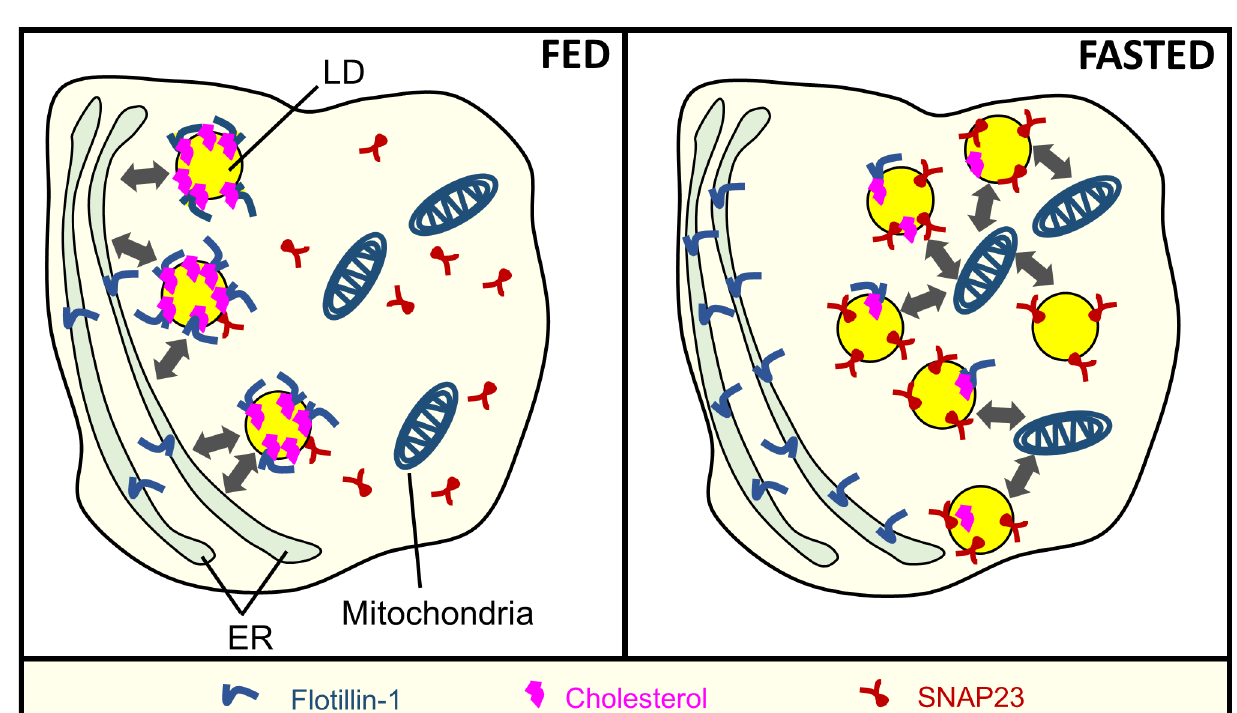
Fig 5. Working model for feeding-fasting dependent recruitment of microdomain associated proteins to lipid droplets in the liver. Fed state: Free cholesterol levels increaseon the LDs, and may mediateER-LD interactions (thick doubleheadedarrows). Flotillin-1 is trafficked to LDs from ER, possiblybecauseof enhanced ER-LD interactions. Cholesterol bindingproteins (such as flotillin-1)therefore increase on LDs in the fed state. These proteinsmay reside on cholesterol inducedmicrodomains on the LD membrane. Fasted state: There are more LDs in the liver due to increasedflux of FA from adiposetissue into liver. However, these LDs appearto interact less with the ER. The reducedER-LD interactions are evidencedby reducedtransfer of GPAT4 to LDs from the ER (not shown in the schematic). Reduced ER-LD interactionsmay also block the transfer of flotillin-1to LDs. However, proteins like SNAP23 which are suppliedto LDs from sources other than ER (probablycytosol), are now abundant on the LD membrane. High levels of SNAP23 on LDs increase the interaction between LDs and mitochondria (grey arrows), as evidencedby presenceof mitochondrial marker proteinson LDs (e.g. VDAC-1; not shown in the schematic).